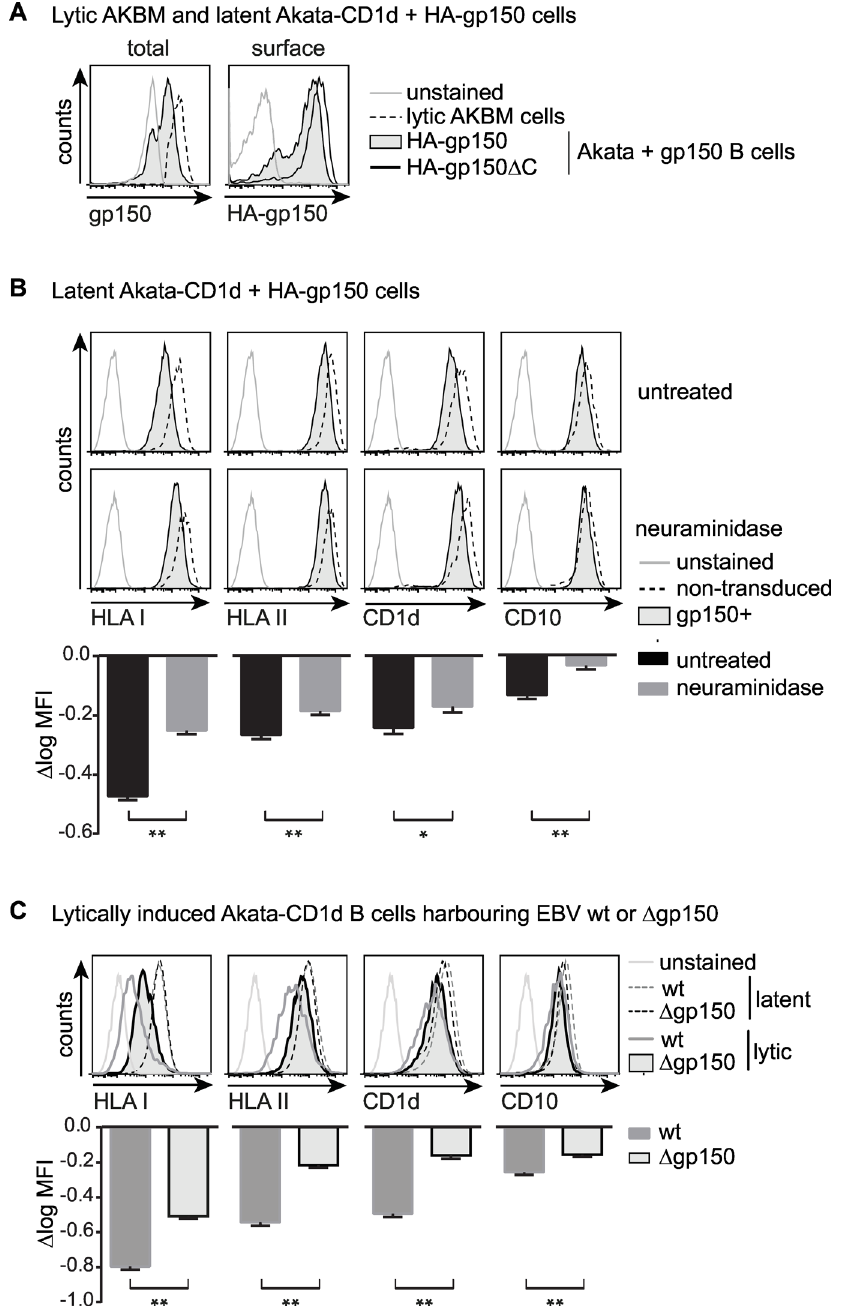
Fig 7. Glycan shielding of surface Ag-presenting molecules by gp150 occurs in human B cells and is reversed during productive EBV infection when gp150 is deleted. A-B) Latent Akata Δ gp150 cells were lentivirally transduced to co-express either HA-gp150 or HA-gp150 Δ C and GFP (from EF1a and PGK promoters, respectively) and were puromycin-selected to obtain pure populations of gp150 + cells. B cells already grow in suspension and gp150-positive B cells were maintained in culture for several weeks, indicating that gp150 expression was not toxic to the cells. A) Flow cytometry was used to assess total (intracellular staining with anti-gp150 Ab on permeabilized cells) and surface (anti-HA Ab on non- permeabilized cells) levels of EBVgp150. Expression levels of gp150 were compared to lytically induced AKBM cells (20 hours anti-human IgG treatment, rat CD2GFP + cells). B) Akata+gp150 and non-transduced control cells were left untreated or were treated with neuraminidase (1U/ μ l, 60 min, 37°C). Surface levels of Ag-presenting molecules and cellular CD10 as a control were compared to gp150 - non-transduced cells.